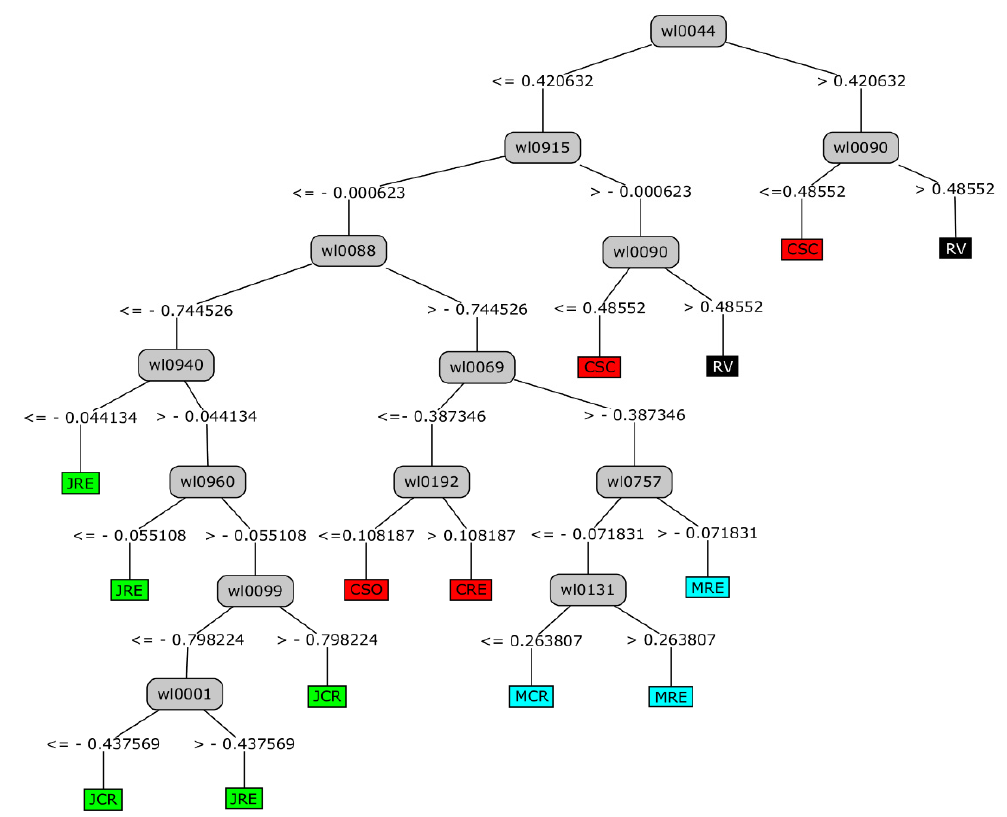
Figure 2. Decision tree (DT) developed for the tool based on the HCM carried out in a previous work [17].